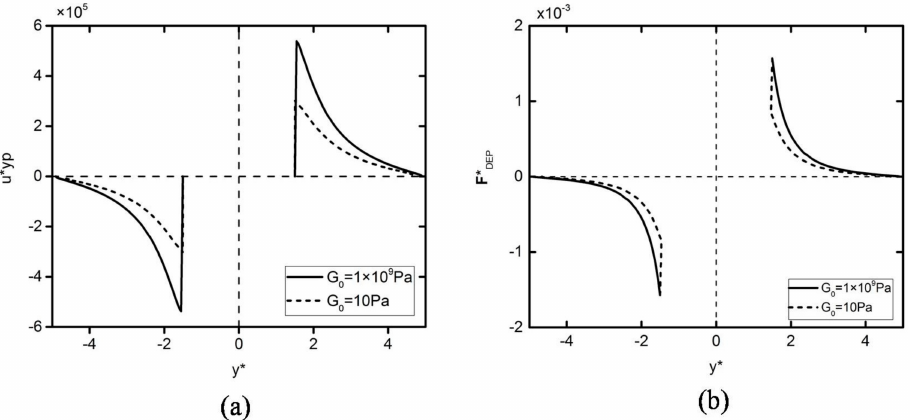
Figure 7. Velocity ( a ) and DEP particle–particle interaction force ( b ) variations of the two particles initially located at ( x ∗ , y ∗ ) = ( 0, ± 1.5 ) subjected to an external electric field E ∗ = 0.05. The solid lines and dashed lines in ( a , b ) represent G 0 = 1 × 10 9 Pa and G 0 = 10 Pa,